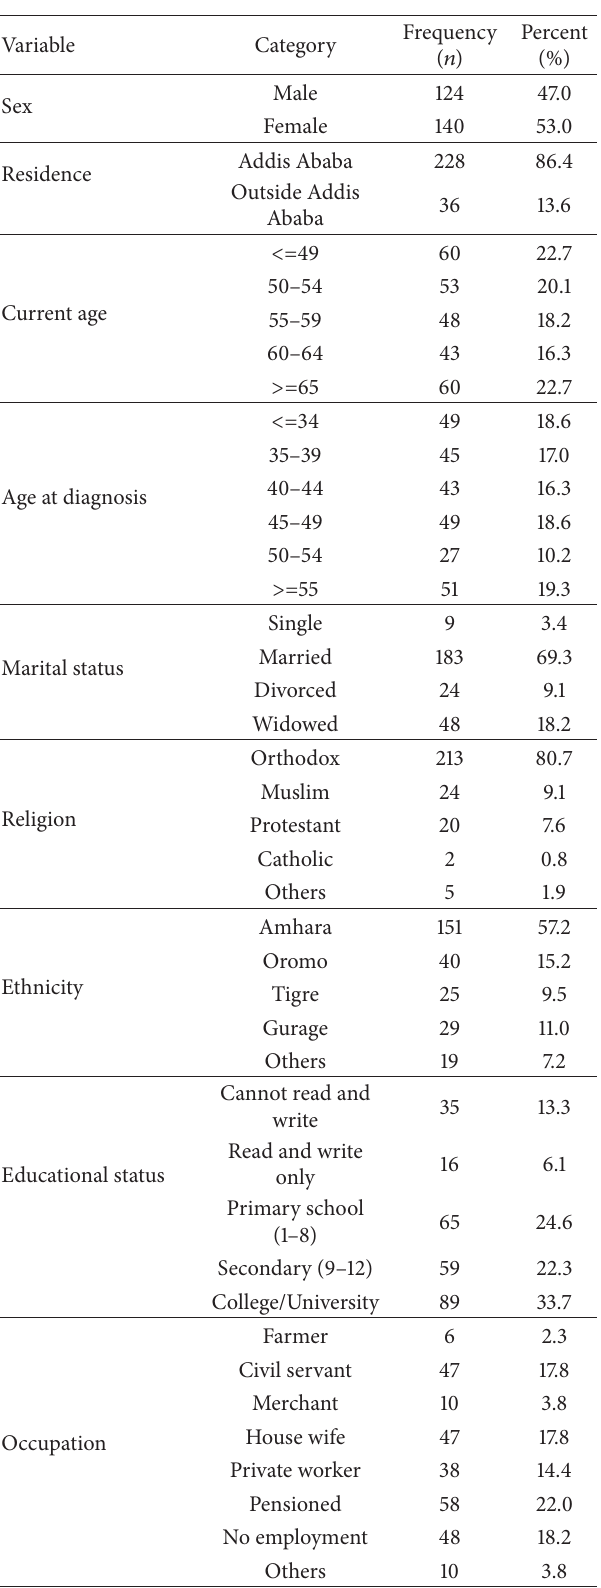
Table 1: Sociodemographic characteristics of type 2 diabetic out- patients in Black Lion General Specialized Hospital, Addis Ababa, Ethiopia, 2013. ( 𝑛 = 264 ).